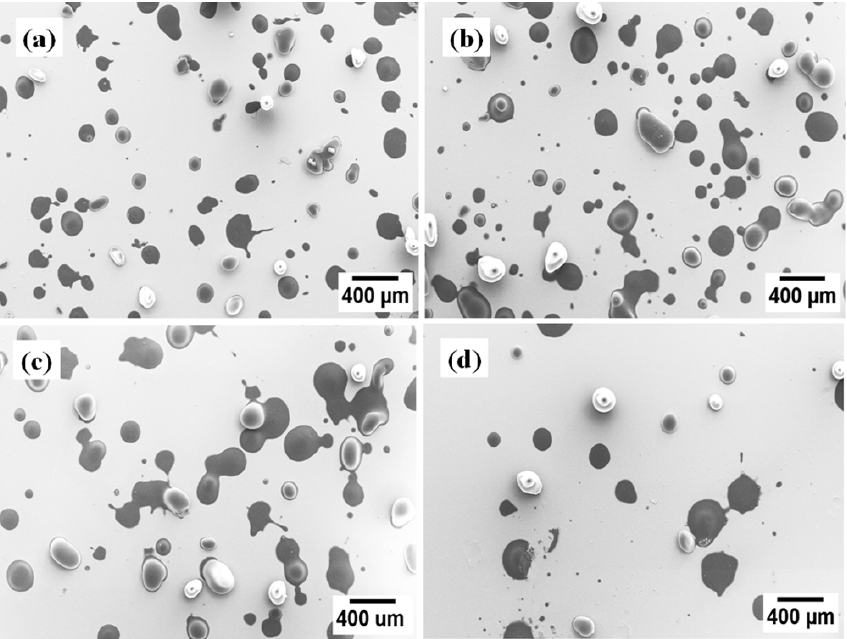
Figure 11. The single splat deposit on heated mild steel substrates at ( a ) 15 cm stand-off distance; ( b ) 20 cm stand-off distance; ( c ) 25 cm stand-off distance and ( d ) 30 cm stand-off